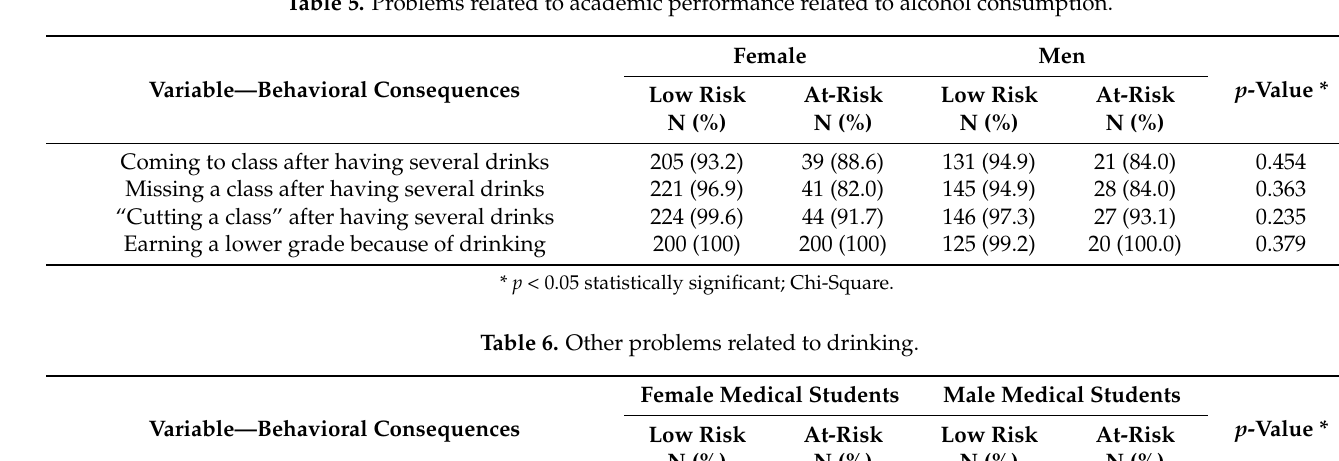
Table 5. Problems related to academic performance related to alcohol consumption.